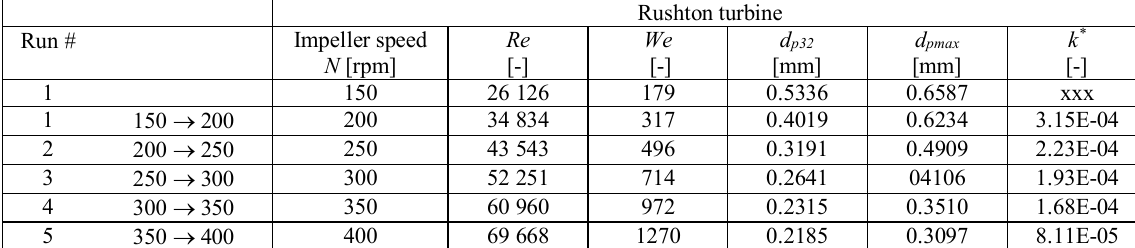
Table 8. Kinetic model parameters – Rushton turbine